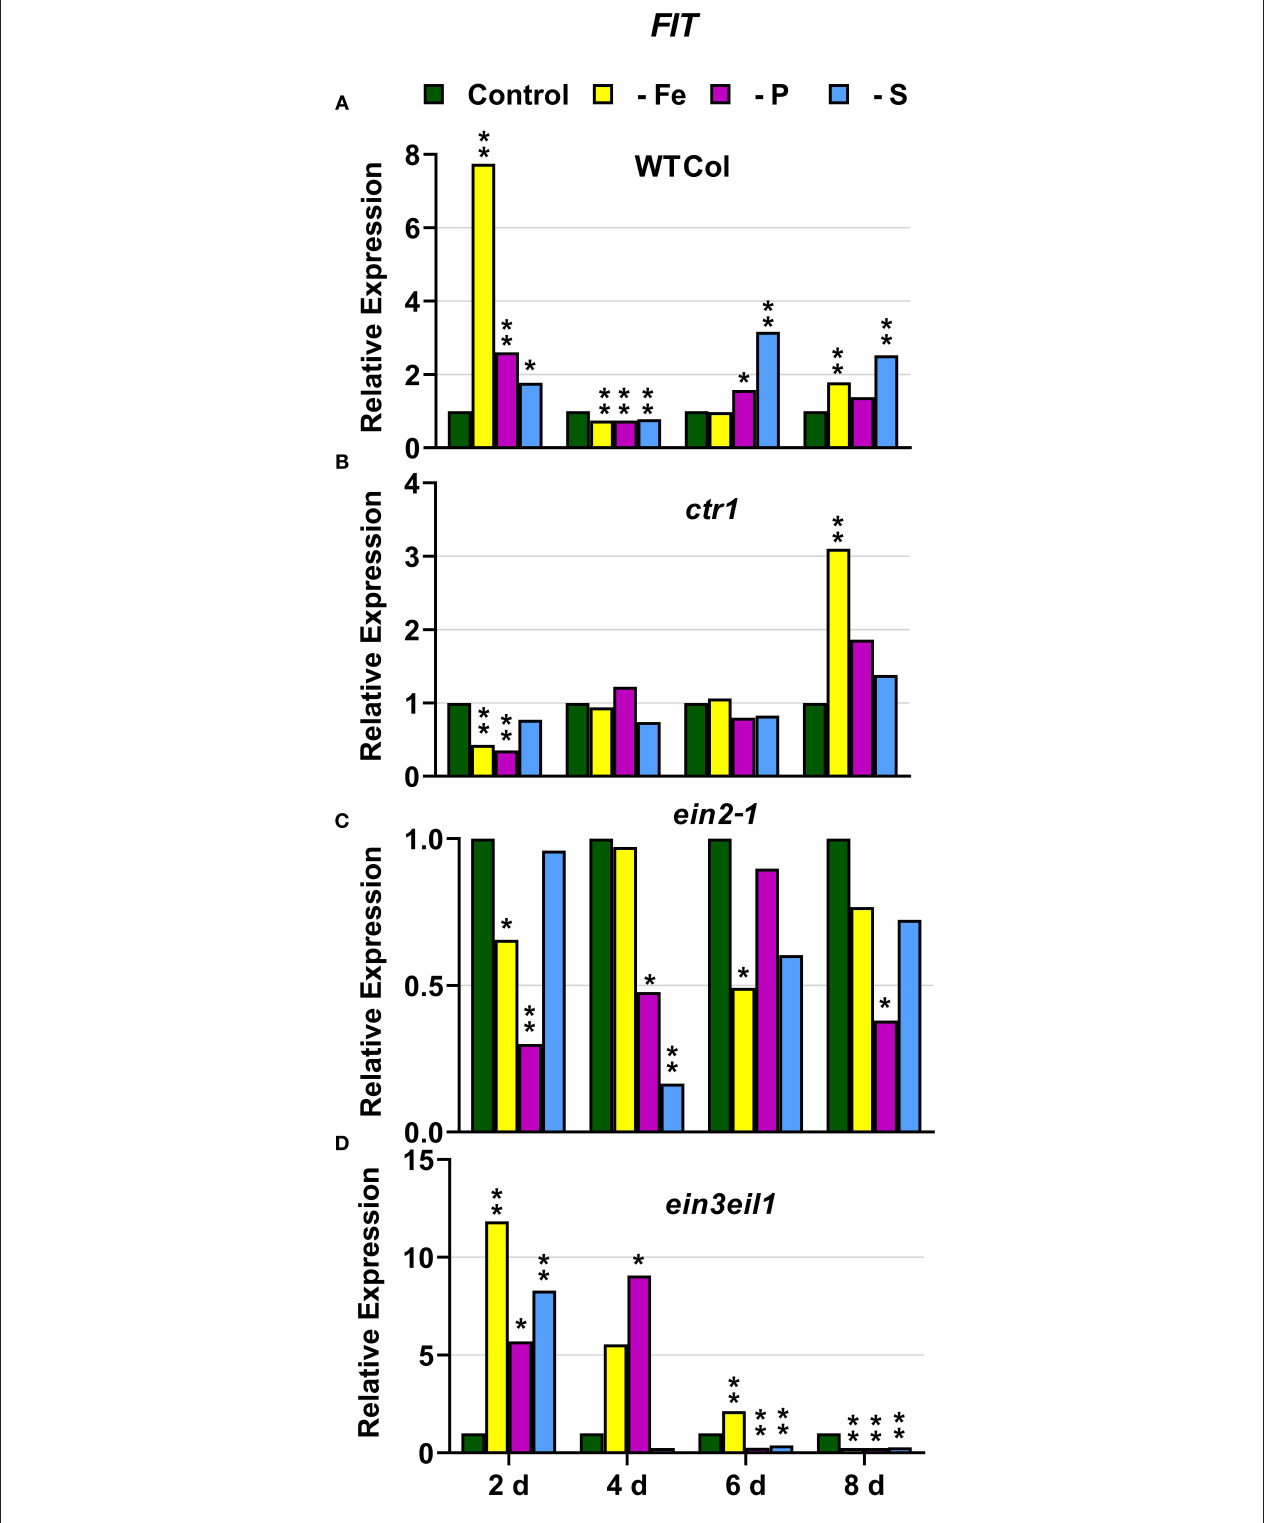
FIGURE 3 | Effect of Fe, P or S deficiency on the expression of the Fe-related gene FIT in roots of the Arabidopsis WT Columbia and its ethylene mutants ctr1 , ein2-1 and ein3eil1 (A–D) . Treatments and gene expression determination as in Figure 1 . Within each day and genotype, * or ** indicate significant differences ( P < 0.05 or P < 0.01) in relation to the control